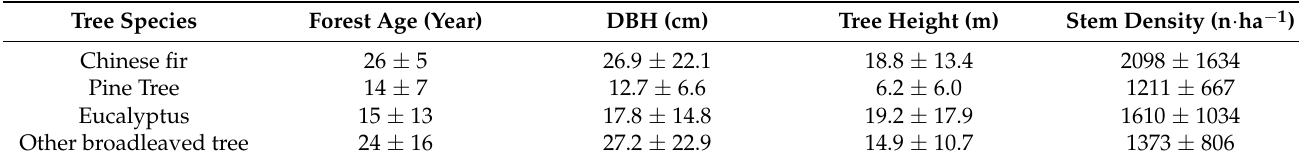
Table 1. Sample plots information.